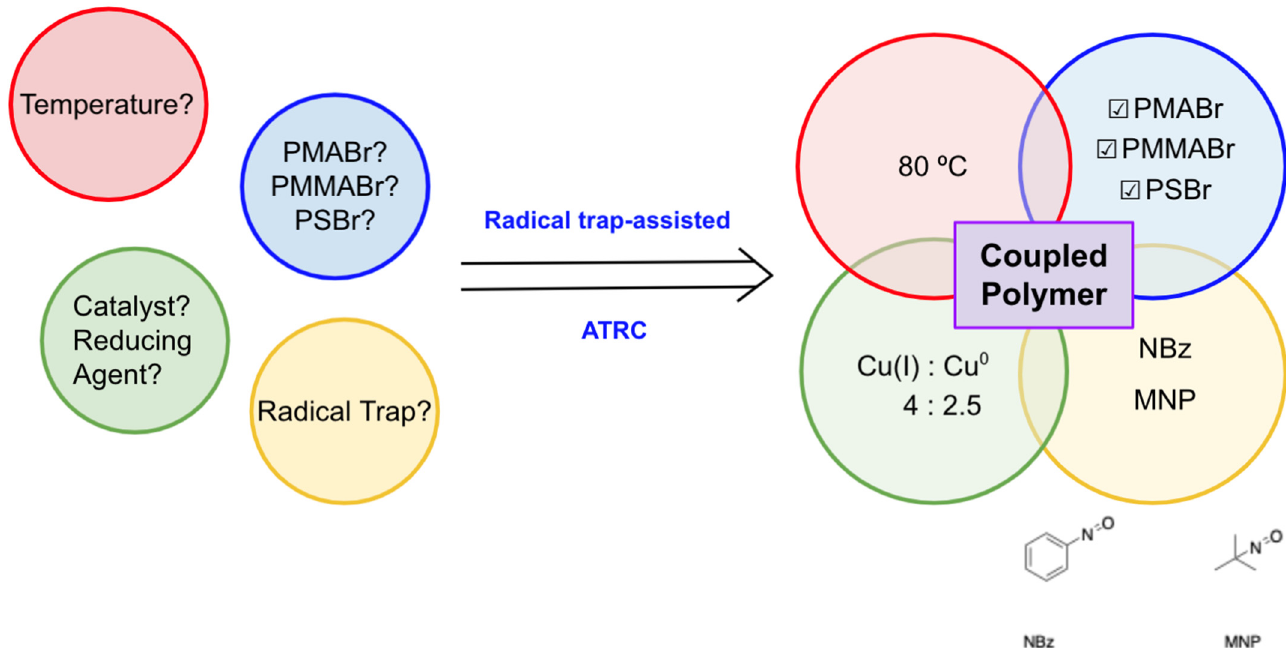
Figure 1. Summary of the challenge of finding common ATRC-type conditions across all three major classes of brominated polymers prepared by ATRP.